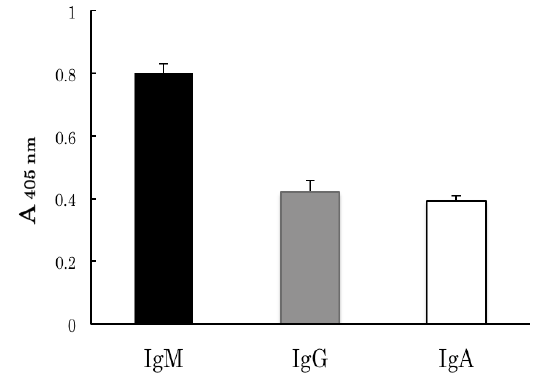
Figure 1. Detection of immunoglobulins in immunocoprecitated partially purified human serum ferritin-binding proteins (FBPs). Immunocoprecitation was performed after complex formation with partially purified FBPs and canine liver ferritin followed by the addition of anti-feline liver ferritin antiserum. Immunoglobulin (IgM: solid bar; IgG: gray bar; IgA: open